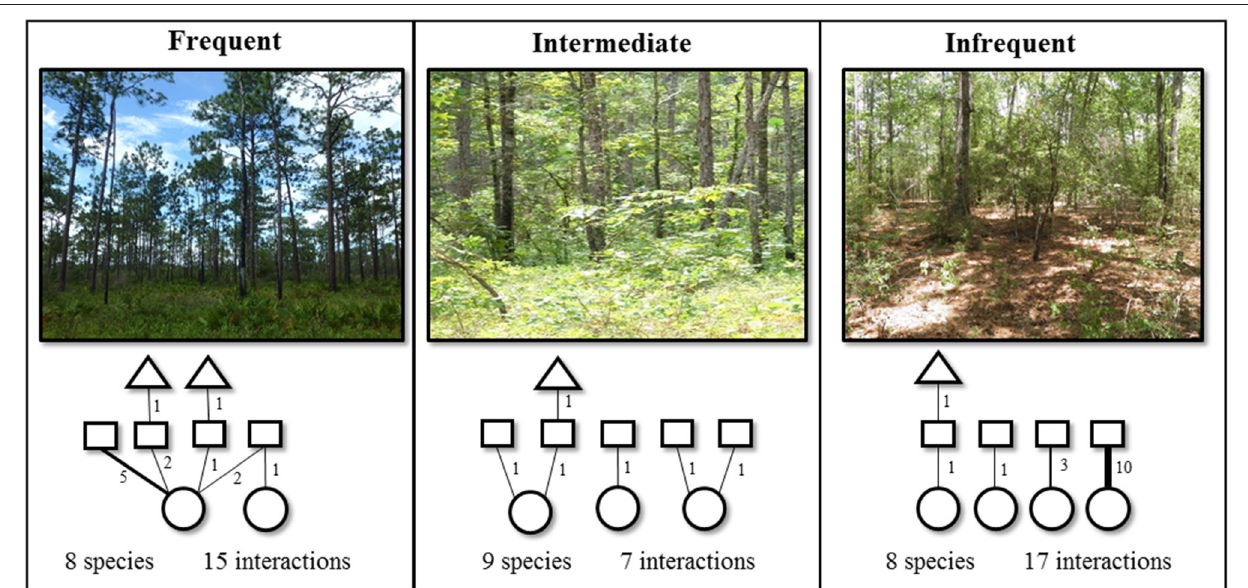
FIGURE 3 | Photo representation of each fire return interval (FRI) category and a sample interaction diversity network found within a single plot in each FRI type. Interactions and their abundances are indicated by solid lines and corresponding numbers, representing interactions between host plants (circles) and herbivores (squares), or between herbivores and parasitoids (triangles), respectively. Each tri-trophic interaction linking a plant, herbivore, and their parasitoid is considered an additional single interaction. Interaction richness and abundance are used to quantify interaction diversity components. Local-scale diversity metrics were calculated with individual plots while regional-scale diversity metrics represent an aggregation of interaction diversity plots and general collections within each FRI